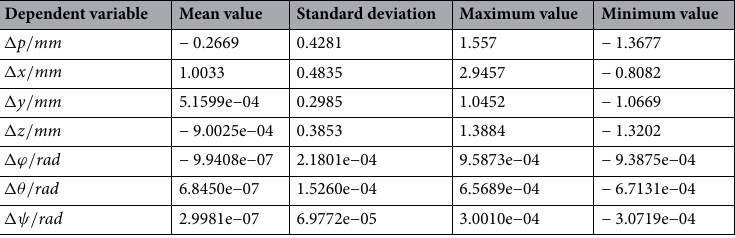
Table 5. Distribution characteristics of terminal